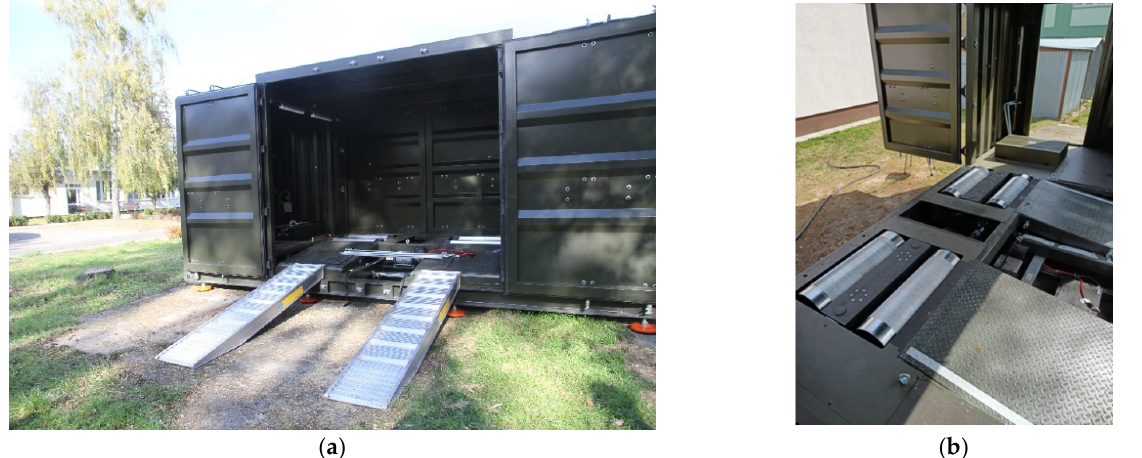
Figure 1. A mobile dynamometer device: ( a ) front view, ( b ) view of the interior of the dynamometer (authors’ source).